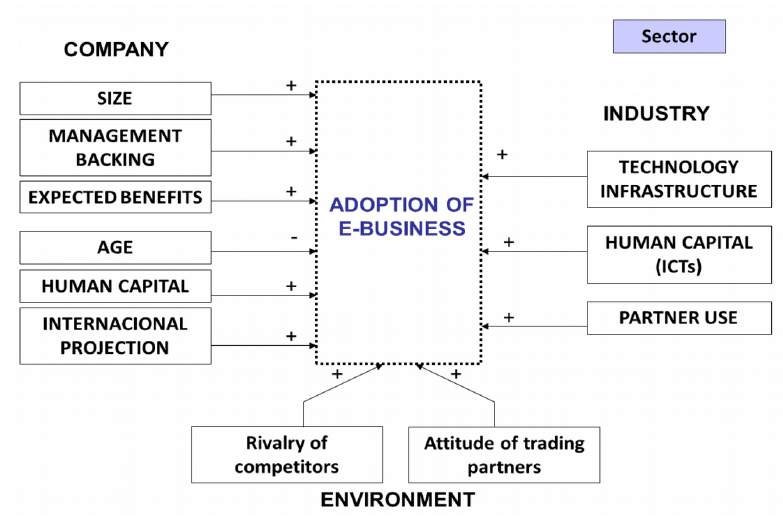
Figure 1. Factors conditioning e-business adoption (García Moreno et al.,